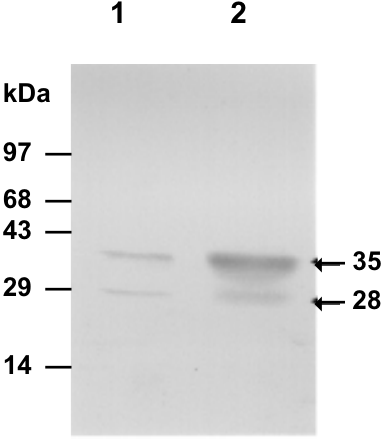
Fig. 1. Induction of chitinase in Pseudomonas fluore- scens treated rice plants. Lane 1, rice plants inoculated with Rhizoctonia solani ; lane 2, Pseudomonas fluore- scens treated rice plants inoculated with R. solani.